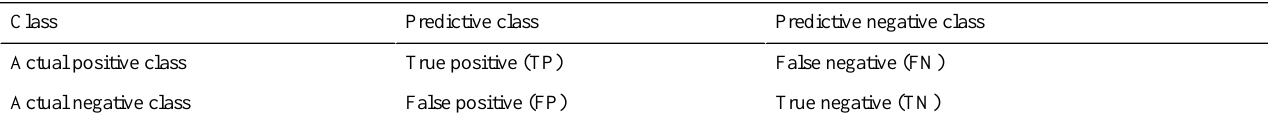
Table 3. Classification confusion matrix.